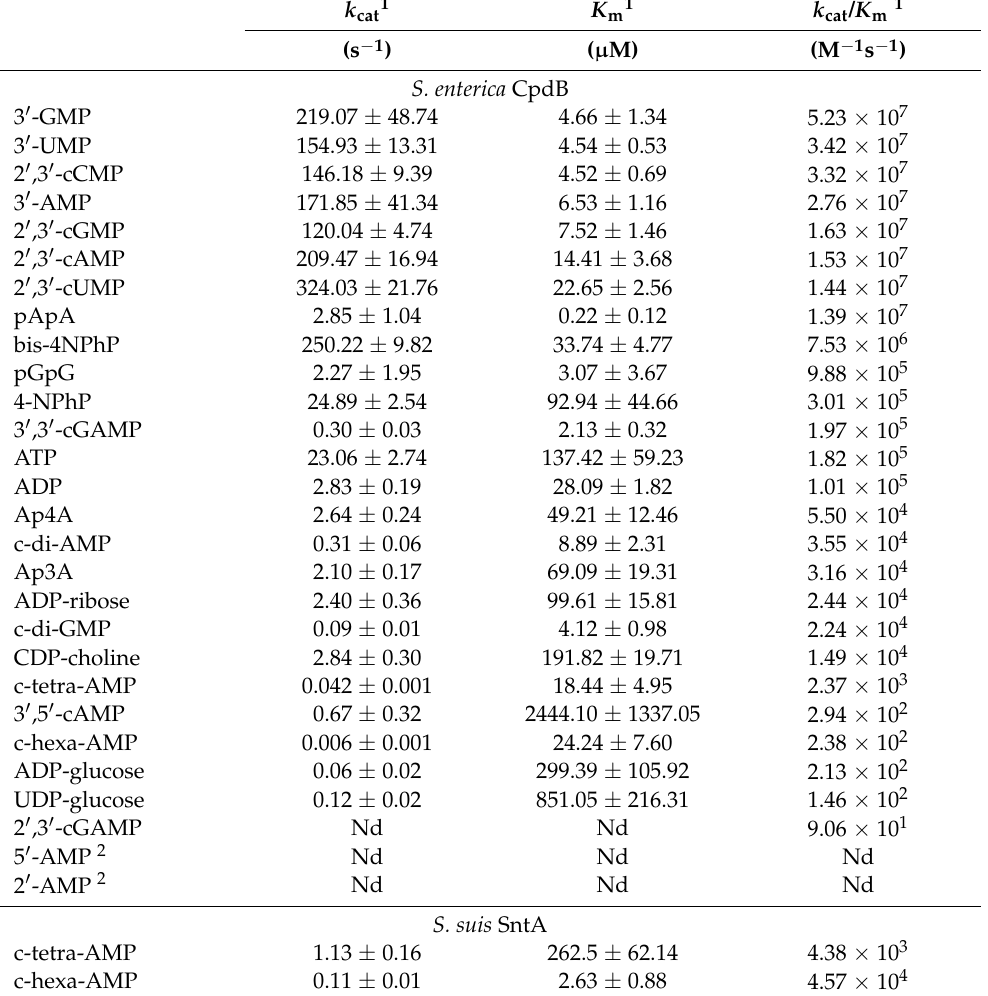
Table 1. Kinetic parameters of S. enterica CpdB. New data for S. suis SntA are shown in the lower part of the table. Data are mean values ± standard deviations of three